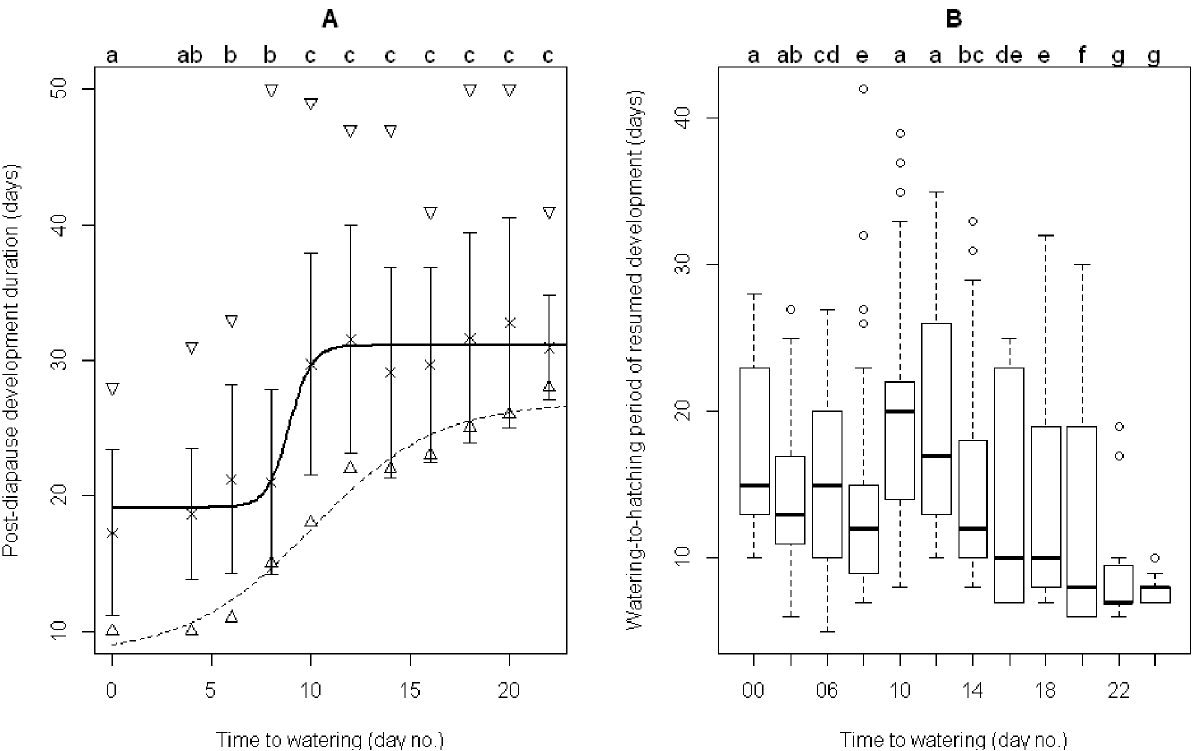
Fig 5. The relationship between post-diapause development duration (A) and watering-to-hatching period of resumed development (B) and the time to watering ( T 2 ) in post-diapause stage for A . lucorum . The triangle ( Δ ), inverted triangle, the cross (×) and bar ( ┬ ) indicate the minimum, maximum, mean and standard deviation of development duration in each treatment, respectively. NDE represents the developmental duration of non-diapause eggs. The thick solid curve indicates the relationship between post-diapause development duration ( Dp ) and time to watering ( T 2 ) (dry days experienced) described by Dp = 19.12 + (31.08 – 19.12) / (1 + exp ((8.90 — T 2 ) / 0.56)). The thin dashed curve indicates the relationship between development duration of the post-diapause stage for the first hatchlings ( D p1 ) and time to watering ( T 2 ) described by D p1 = 8.32 + (26.91 – 8.32) / (1 + exp ((10.07 — T 2 ) / 3.13)). The lowercase letters indicate significant differences at the probability level of